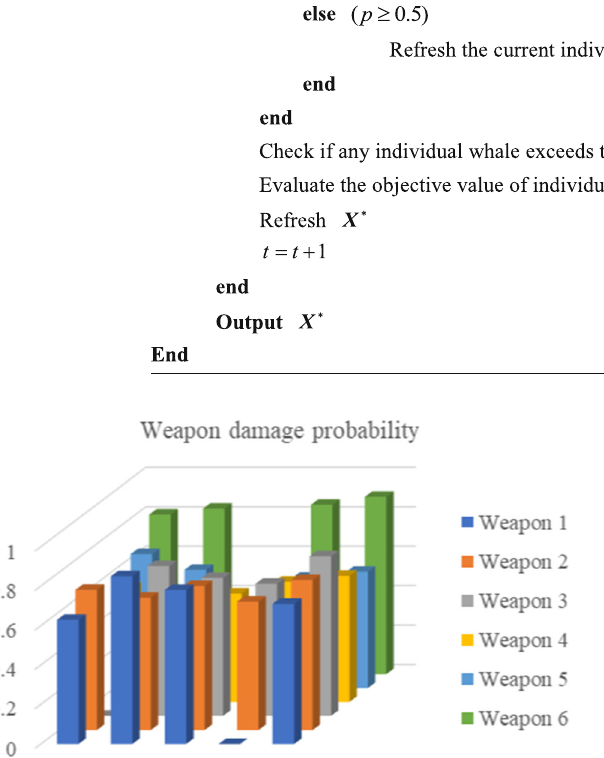
Fig. 5 The histogram of the weapon damage probability for case